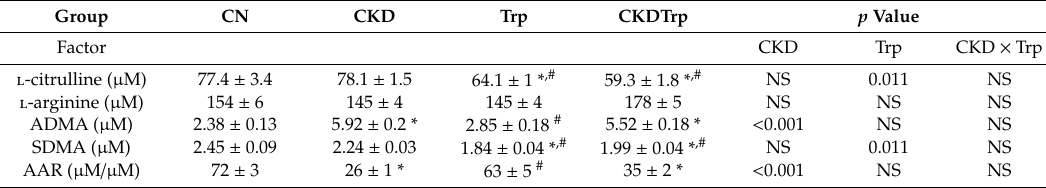
Table 2. Morphological and biochemical values in di ff erent experimental groups.